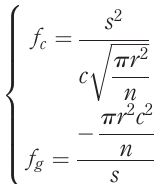
Figure 1. Different stages of the formation of the crowd intelligence network. It includes the initial uniform distribution pattern, the agent node linking pattern and the evolutionary